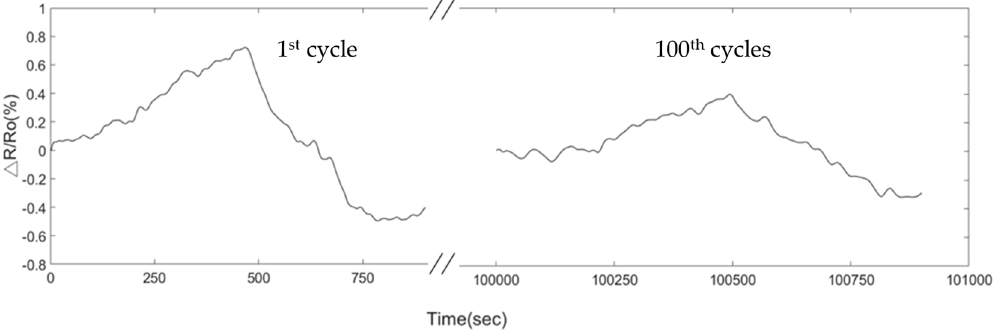
Figure 15. Degradation of the sensor after 100 cycles upon exposure to 604.6 ppm of acetone at 45 °C operating temperature.